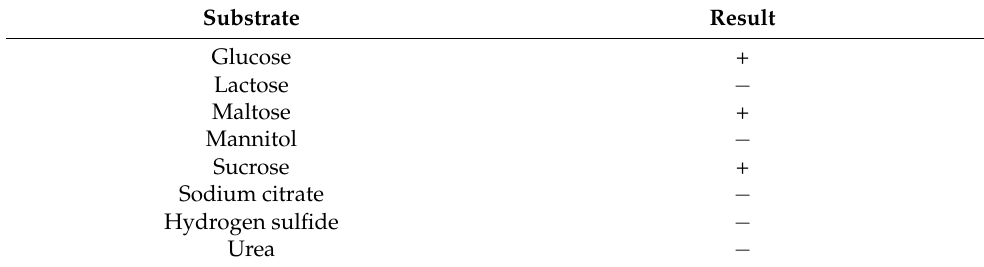
Table 1. Bacterial biochemical